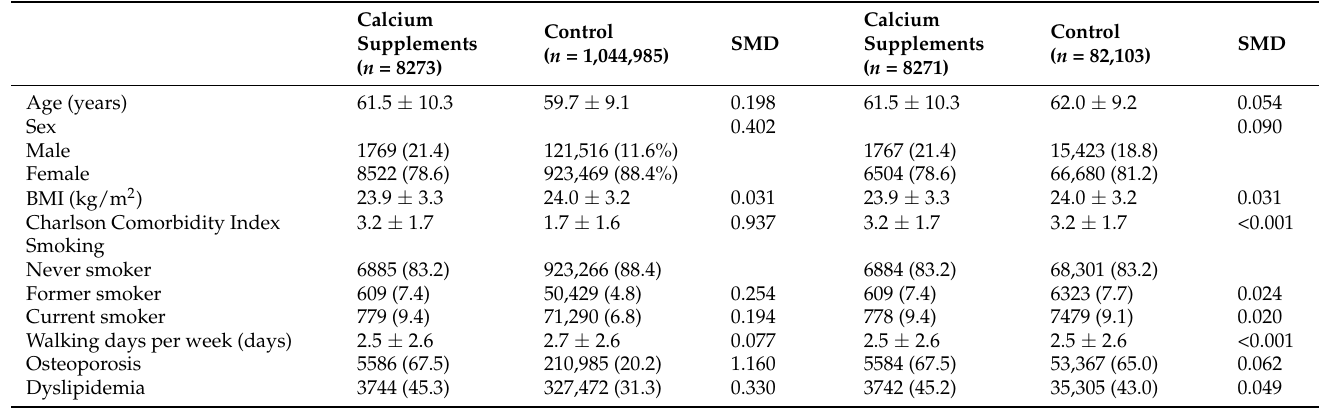
Table 1. Baseline characteristics of study participants according to calcium supplement prescription before and after propensity score matching.